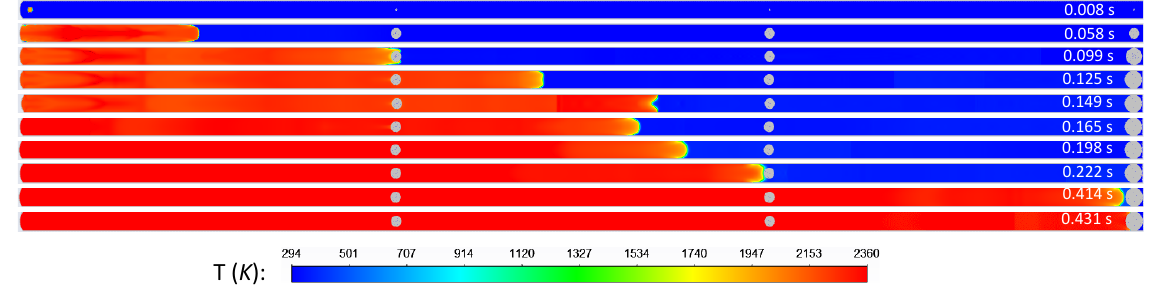
Figure 17. Flame propagation after explosion occurs for the scenario in which both Obstruction 1 and Obstruction 2 are half inflated and Obstruction 3 is fully inflated (with a 100% blockage).